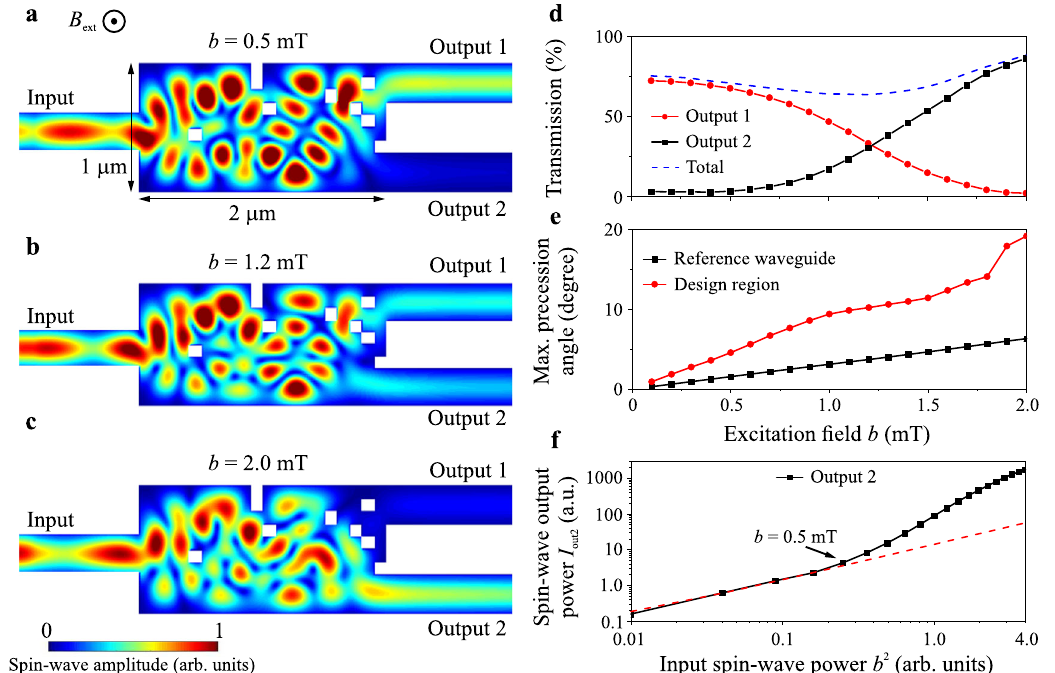
Fig. 4 Inverse-design nonlinear magnonic switch. a – c The normalized spin-wave amplitude distribution for excitation fi elds ( a ) b = 0.5 mT, ( b ) b = 1.2 mT, and ( c ) b = 2.0 mT. One can clearly see that the low-power spin wave is guided into output 1 and the high-power spin wave (the power is increased by a factor of 16 times) is guided to output 2. The design region was increased twice to reach high ef fi ciency of the nonlinear switch. d The spin-wave transmission to the different output waveguides and the summarized total transmission (dashed blue line) as a function of the excitation fi eld b . The decrease in the total transmitted power suggests that a part of spin-wave energy is stored in the form of standing waves in the structure. e The maximal precession angle in the reference straight waveguide (black dots line) and design region (red dots line) as a function of the excitation fi eld b . f The absolute spin-wave output power at the second output waveguide as a function of the input power (the square of excitation fi eld b 2 ) and the linear fi t to the fi rst four points (red dashed line). The nonlinear properties are getting pronounced for the microwave fi elds >0.5 mT. Number of iterations is